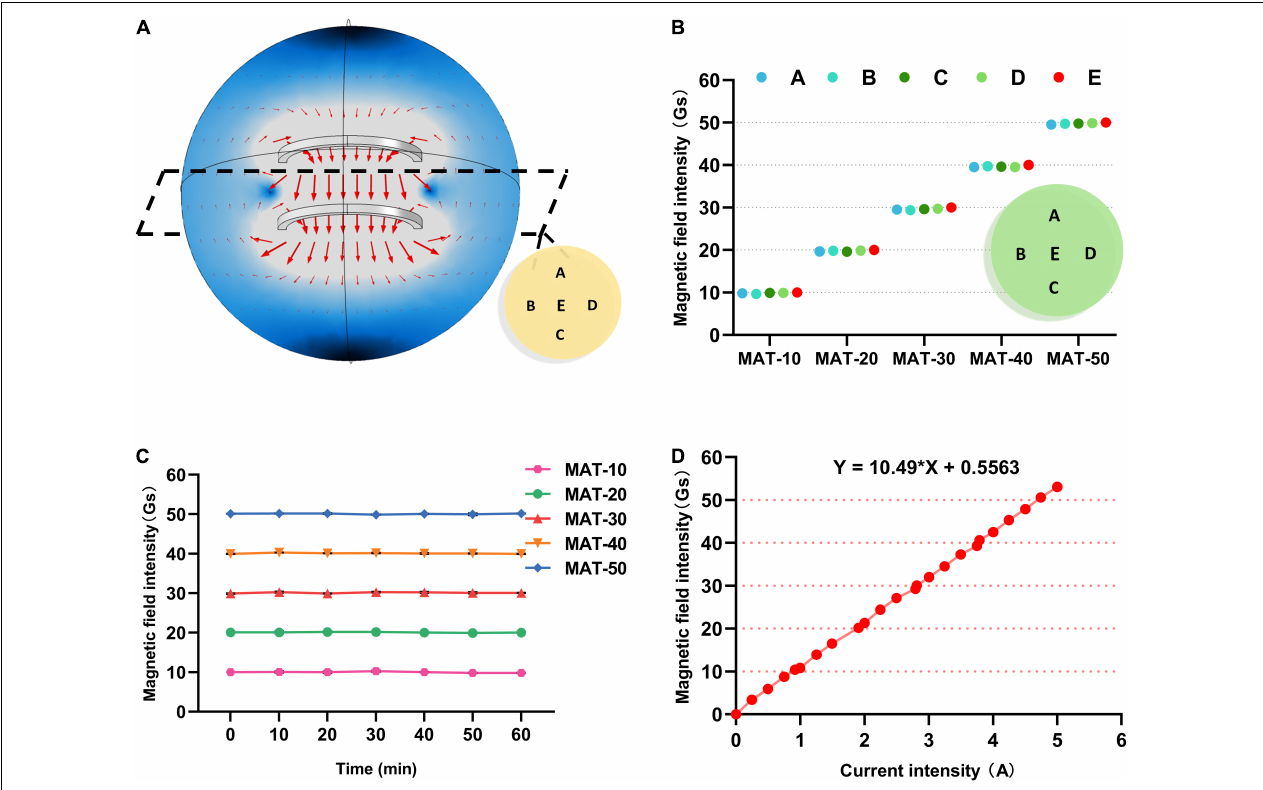
FIGURE 2 | Simulation and Characterization of SMF experimental apparatus. (A) The general law of the magnetic induction direction distribution in the coil. (B) The magnetic field intensity value of each point A, B, C, D, E on the sample plate of each group in the MAT treatment group. (C) The magnetic field intensity value at the center of the tray (point E) during MAT experiments. (D) The relationship between the magnetic induction intensity of the coil and the supply current.